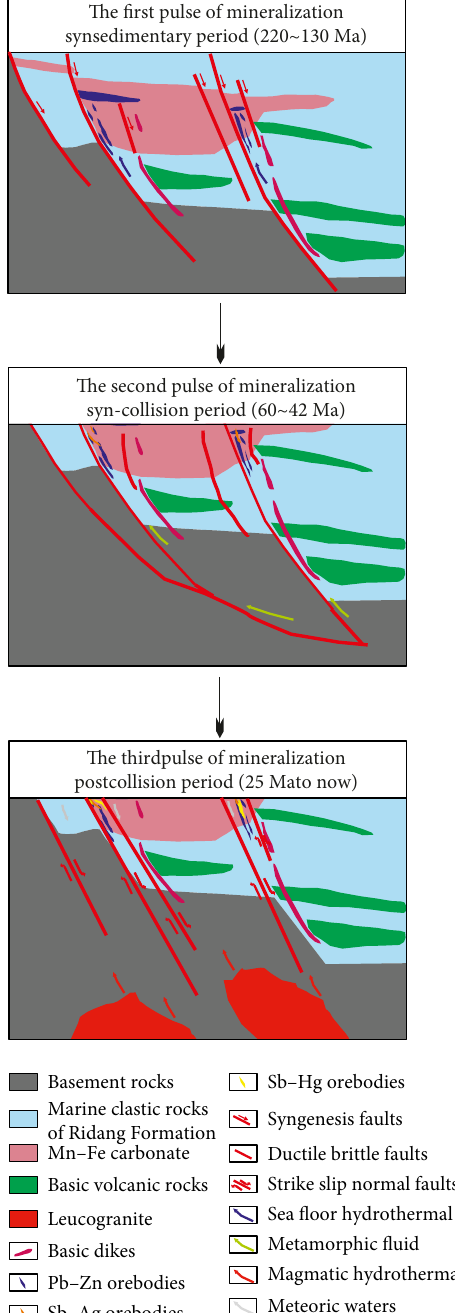
Figure 18: The ore-forming model for three pulses of mineralization in the Keyue